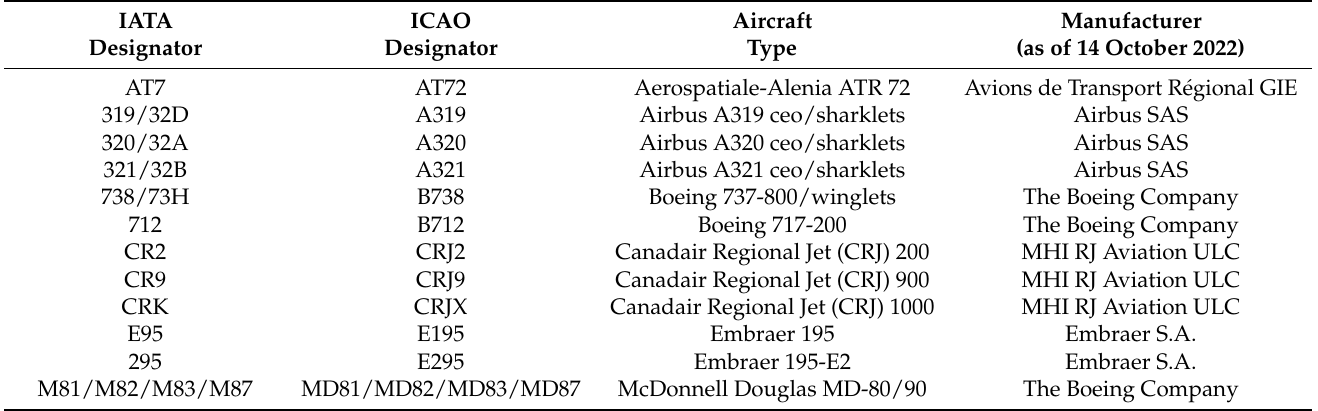
Table A1. List of Commercial Airplanes Considered in the